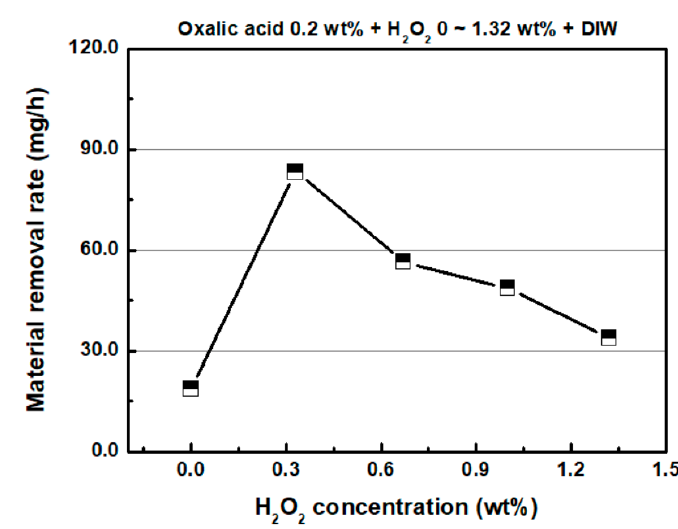
Figure 6. Material removal rate as a function of H 2 O 2 concentration (oxalic acid concentration: 0.2 wt %).